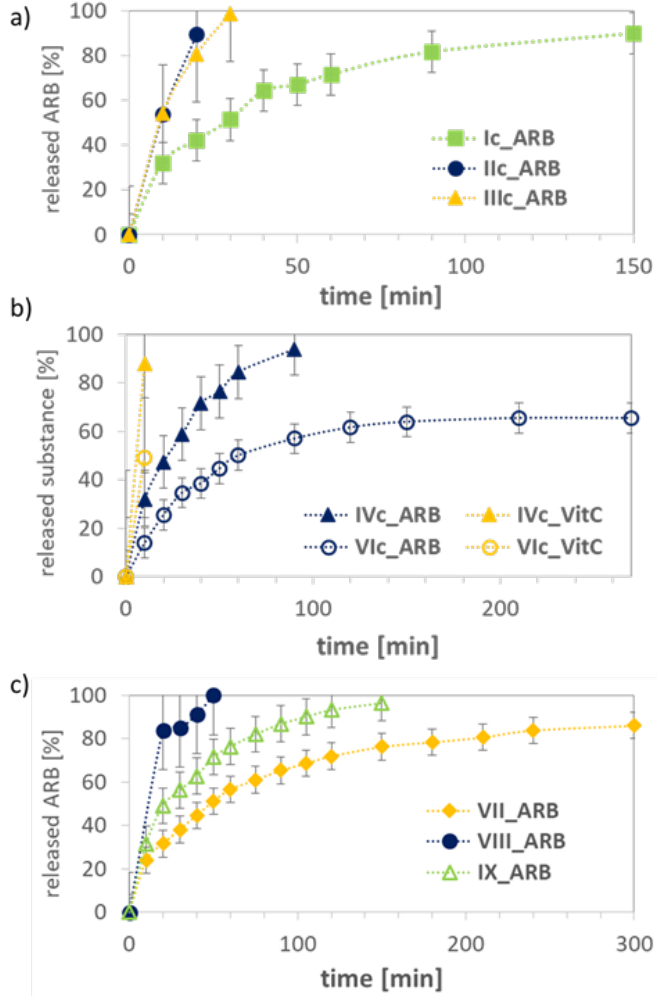
Figure 10. Release profiles for micellar systems formed by graft copolymers ( a , b ) and linear copolymers ( c ).